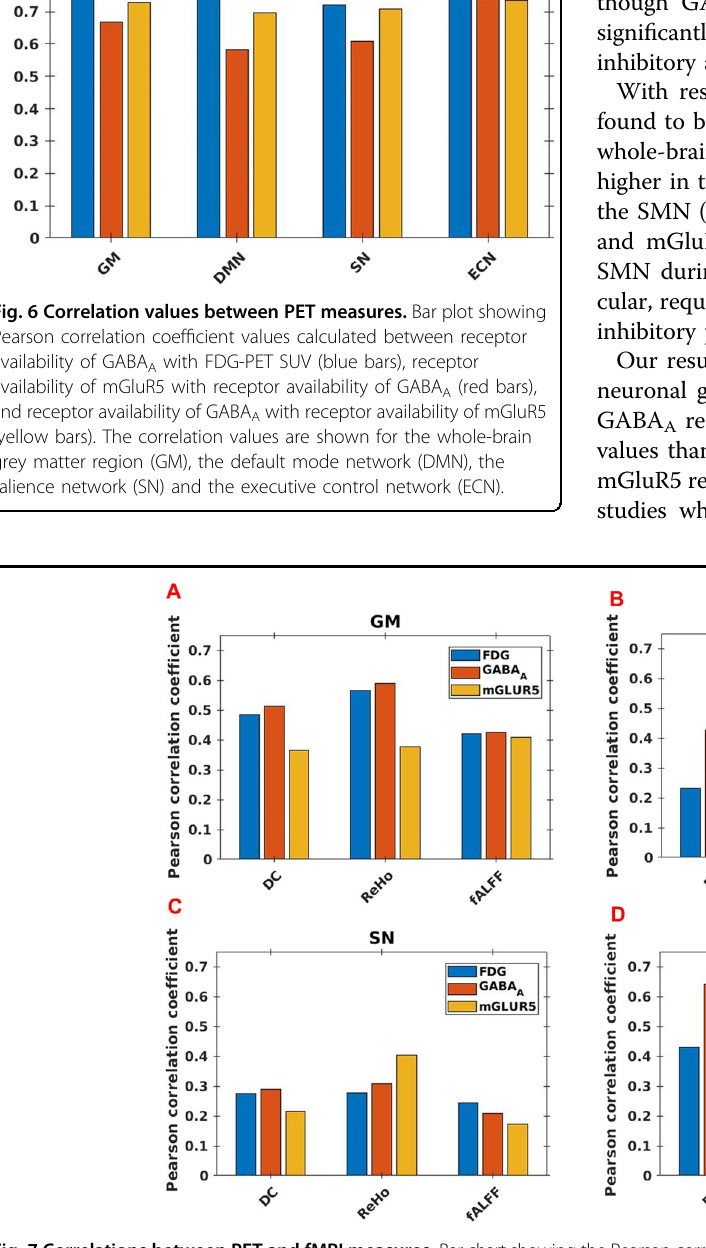
Fig. 7 Correlations between PET and fMRI measures. Bar chart showing the Pearson correlation values between PET and fMRI measures in the whole- brain grey matter (GM), the default mode network (DMN), the salience network (SN) and the executive control network (ECN). Correlations between PET and fMRI regional homogeneity (ReHo), degree centrality (DC) and fractional amplitude of low-frequency fl uctuation (fALFF) measures are